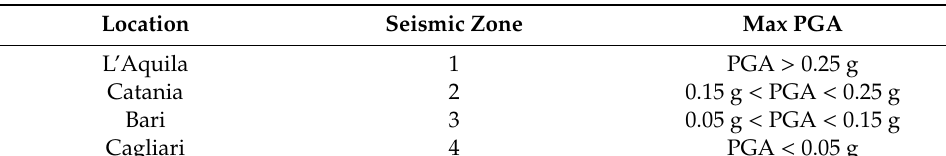
Figure 2. Structure lateral view and cross section ( a ), beam and column cross section ( b ). Table 1. Location of the considered construction sites for the structure. Table 1. Location of the considered construction sites for the structure.